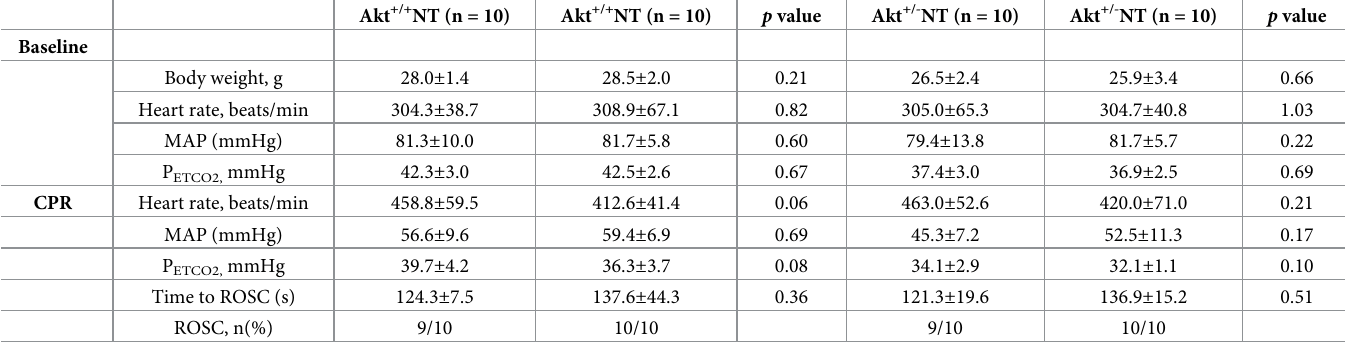
Table 1. Characteristics at baseline and CPR period in Akt +/+ NT, Akt +/+ TH, Akt +/- NT and Akt +/- TH